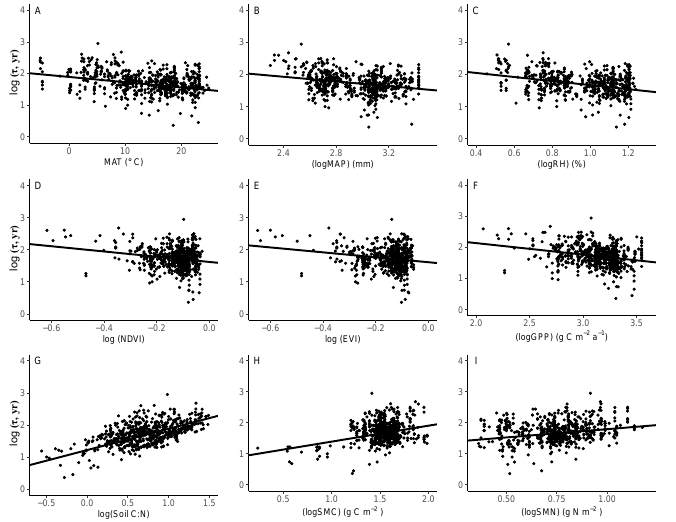
Figure A2. The variation of C turnover time ( τ , naturally log-transformed) according to climatic, soil, and vegetation variables, etc., in the sample mean (A–I) are constant. The fitted lines were deter- mined by GLMM, with the stand types by sites as random factors. The parameters are shown in Table A3.